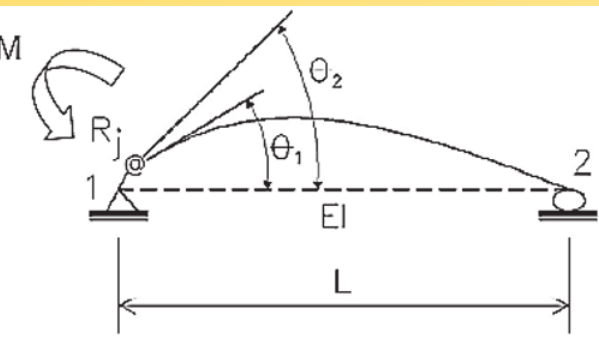
Figura 4 Fator de restrição à rotação – ABNT NBR 9062 [24]